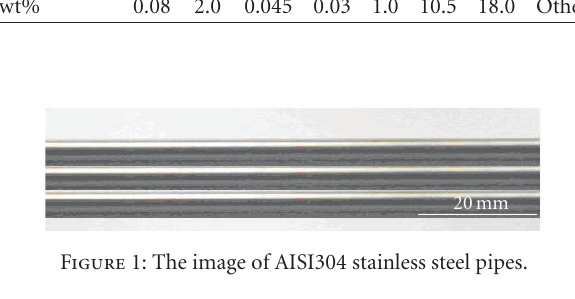
Table 1: The chemical composition of AISI304 stainless steel. Alloy element C